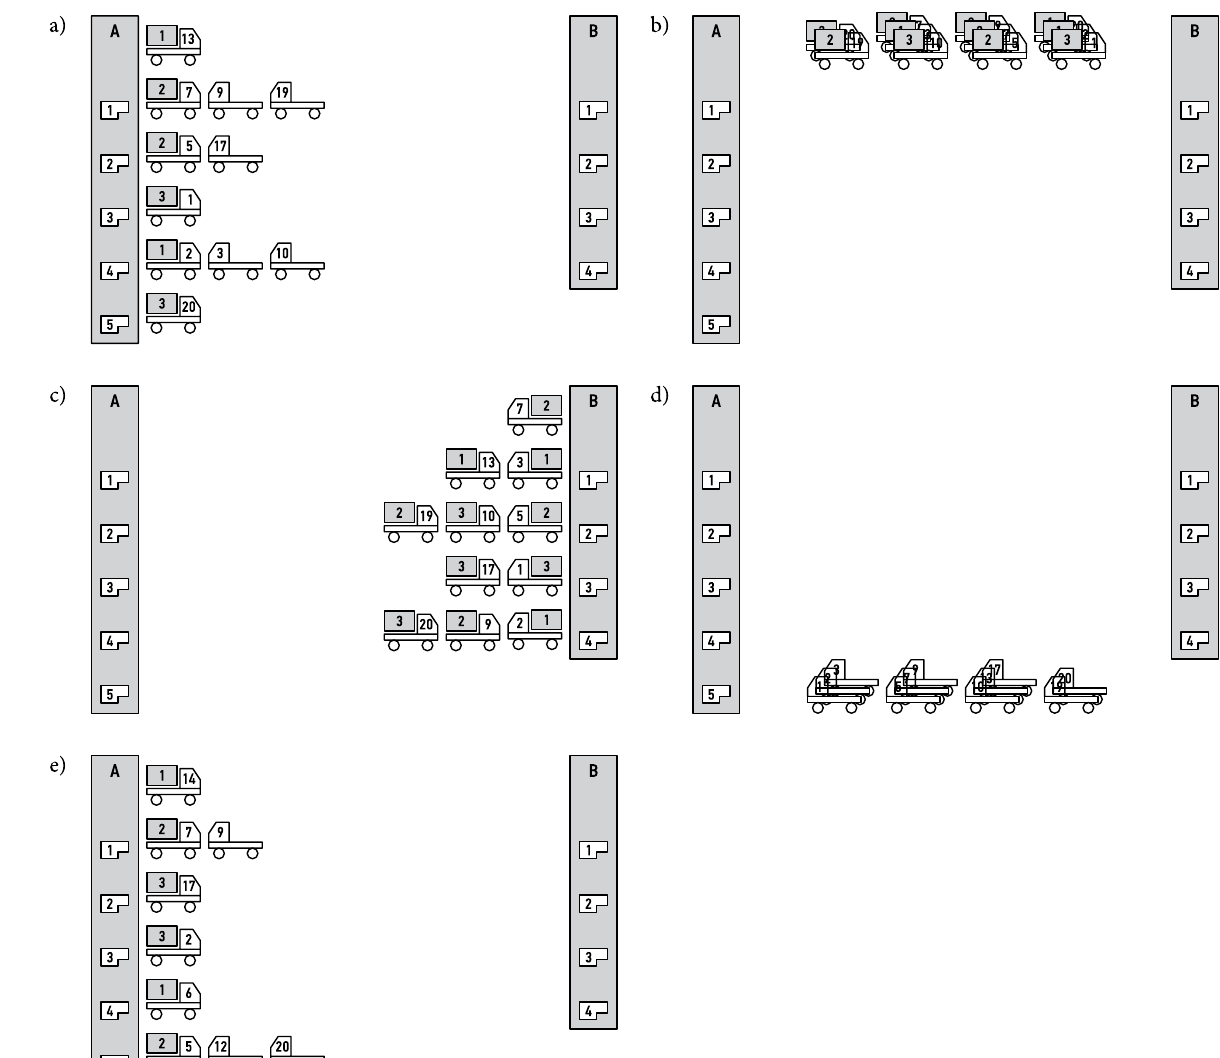
Fig. 3. Group transportation example: a – initial loading at A ; b – moving of a group of vehicles from A to B ; c – unloading at the B ; d – returning of empty vehicles to A ; e – loading of the next group of